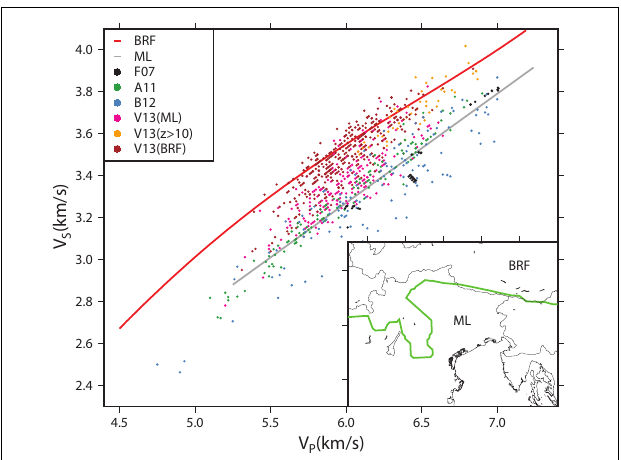
FIGURE 6 | Comparison between the V P and density values as calculated with the relation of Ludwig et al. (1970) (red line) and the values obtained from laboratory measurements (Faccenda et al., 2007) and from gravimetric and seismo-gravimetric inversions in the area (green dots: Dal Moro et al., 1998; brown dots: Ebbing et al., 2001, 2006; yellow dots: Šumanovac et al., 2009; blue dots: Bressan et al.,